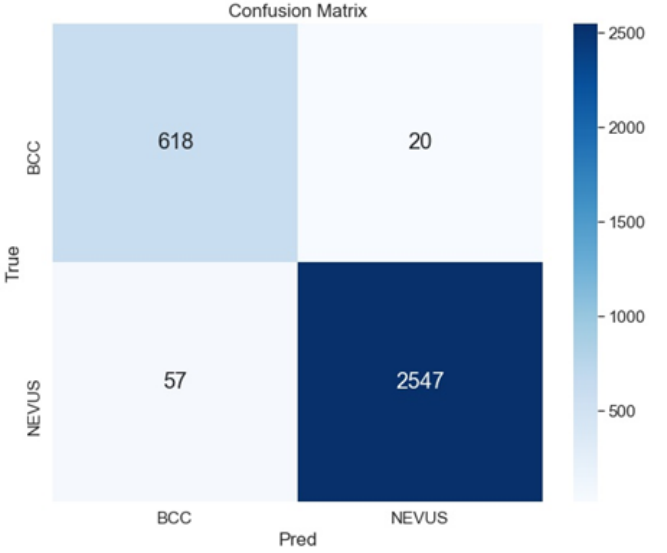
Figure 6. Confusion matrix for the classification of BCC vs. Nevus using the ensemble ArgMax and without previous segmentation.